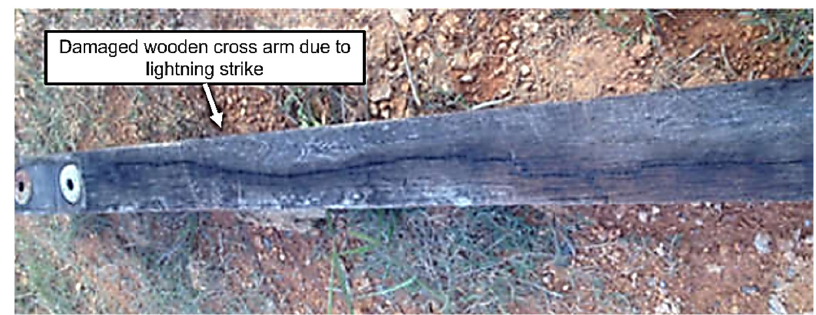
Figure 7. Failure of the wooden cross ‐ arm due to lighting [27].